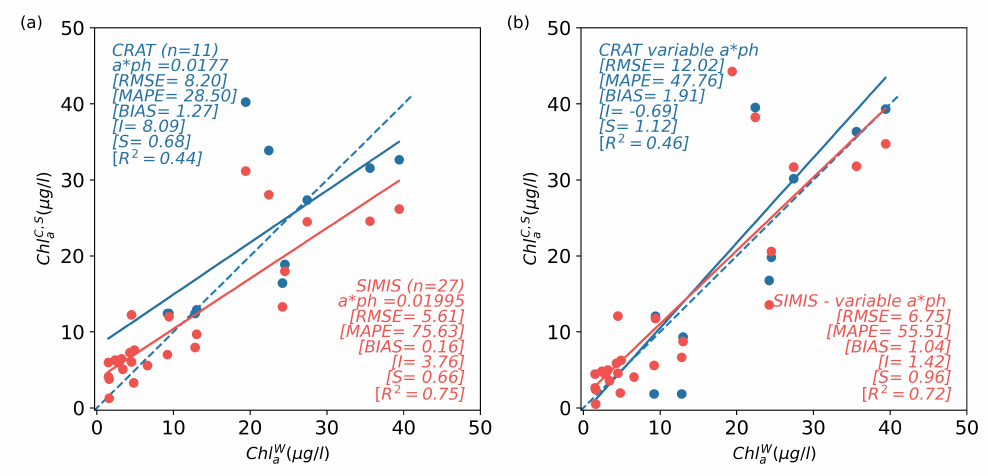
Figure 5. Comparison between Chl a products from the water sampling ( Chl W a ) and when computed with the SIMIS algorithm ( Chl S a , red dots) and CRAT algorithm ( Chl C a , blue dots) using a fixed a ∗ ph ( λ ) ( a ) and variable a ∗ ph ( λ ) ( b ), as shown in Figure 6. Plain lines are the regression lines for each algorithm (red and blue plain lines for the SIMIS and CRAT algorithm, respectively) with I and S being the intercept and slope, respectively. Statistics are computed on 11 points for CRAT and 27 points for SIMIS. Dashed blue line is the 1:1